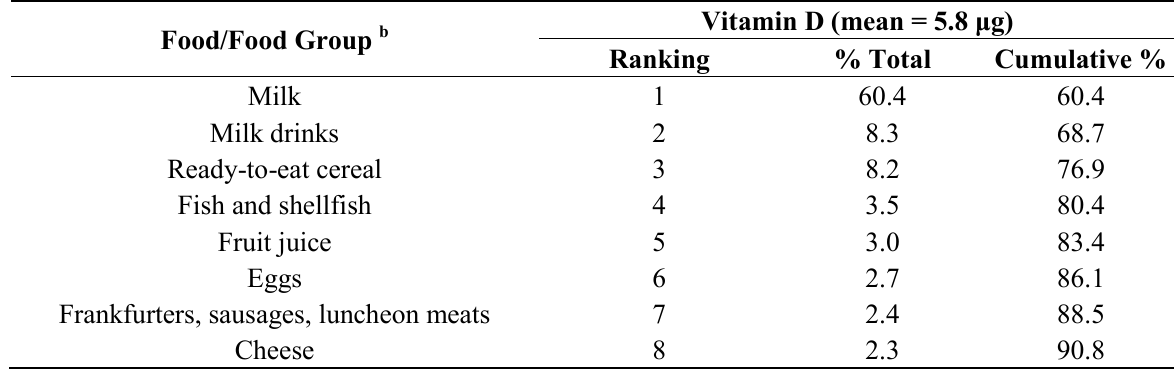
(from NHANES 2003–2006) a